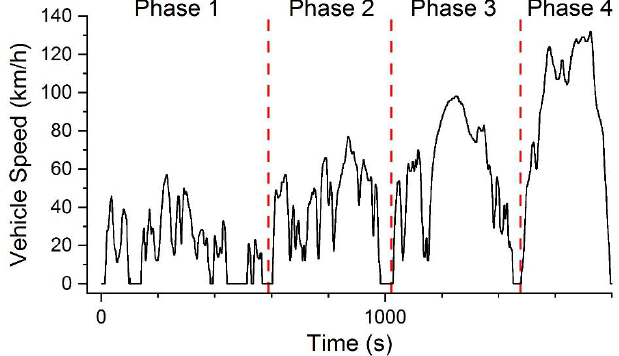
Figure 1. Speed profile of the WLTC.